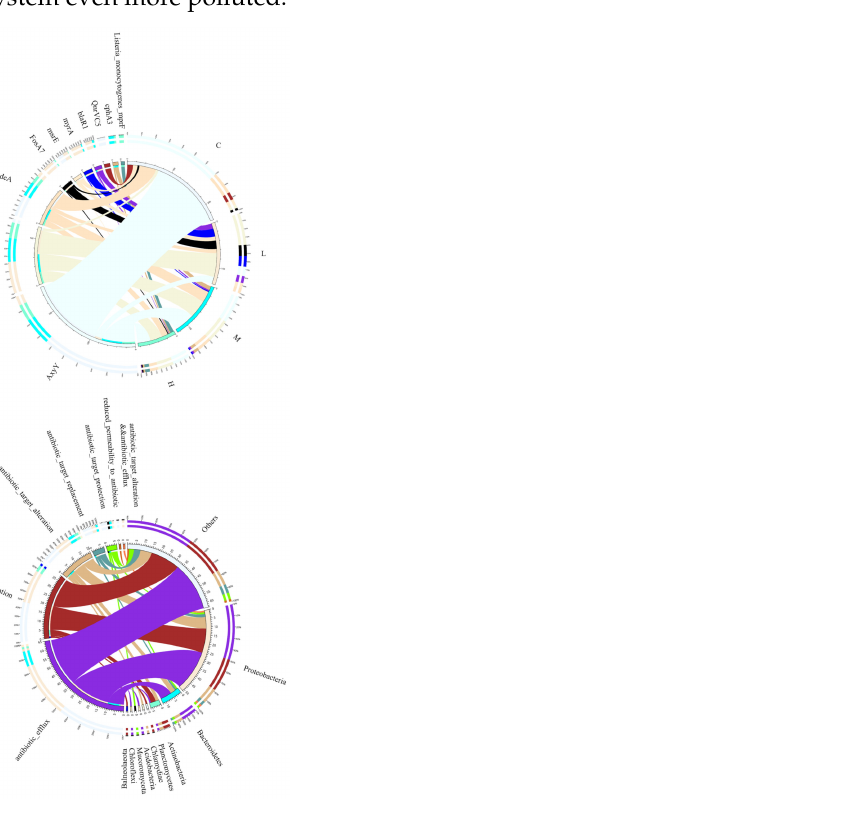
Figure 10. ( a ) Resistance genes overview circos diagram, sample information on the right and ARO information on the left. ( b ) Resistance mechanisms and species overview circos diagram, information on phylum level species is shown on the right, and information on resistance mechanisms is shown on the